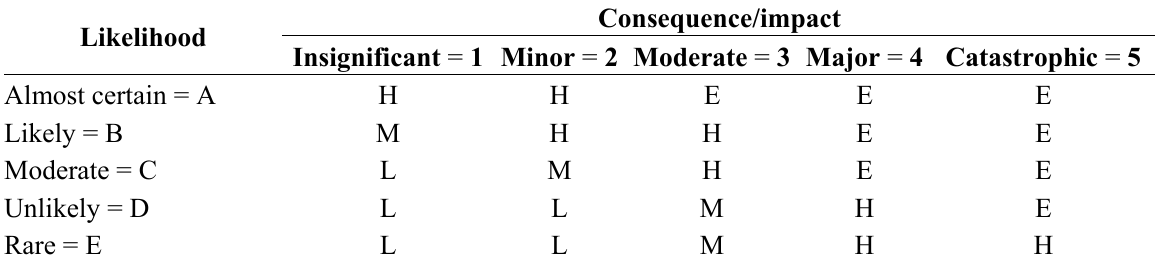
Table 16. Prioritization matrix for qualitative risk analysis